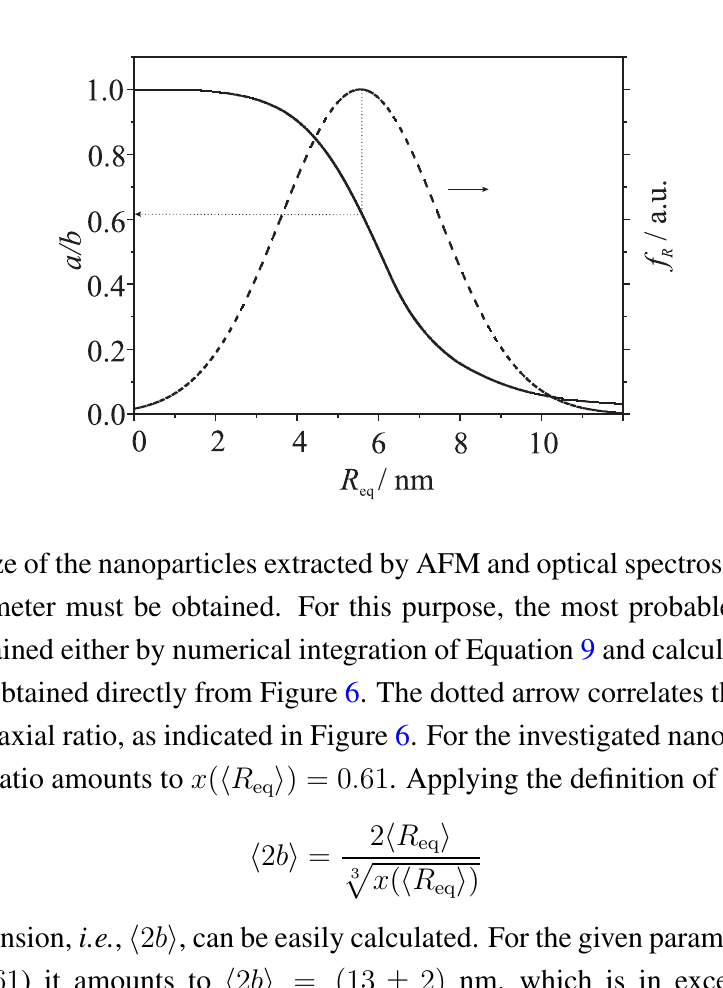
Figure 6. Axial ratio as a function of the equivalent radius (solid line) and size distribution (dashed line). The dotted arrow indicates the axial ratio for the most probable nanoparticle size in the ensemble.